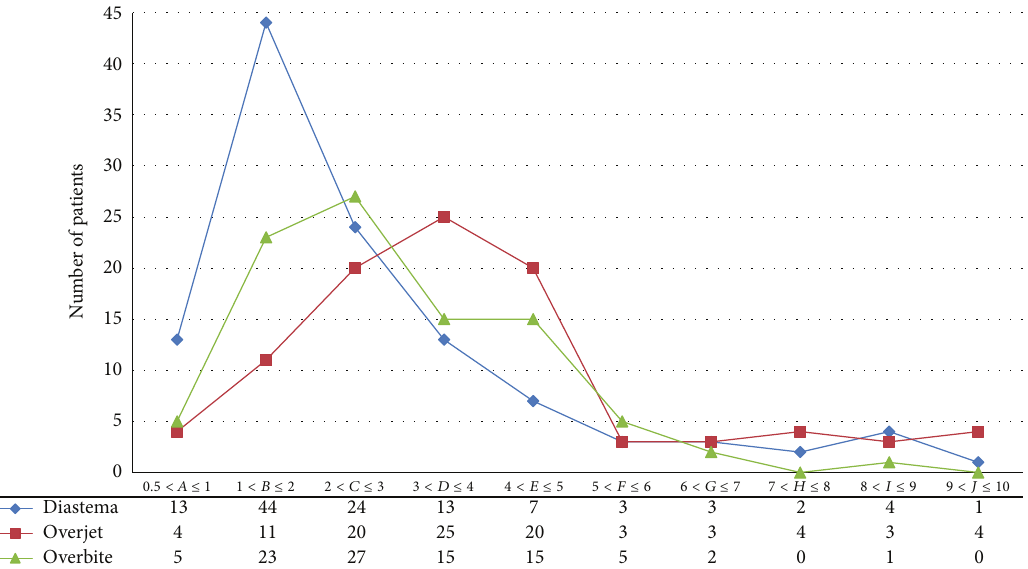
Figure 3: Chart showing the relation of common prevalence between diastema, overjet, and overbite.